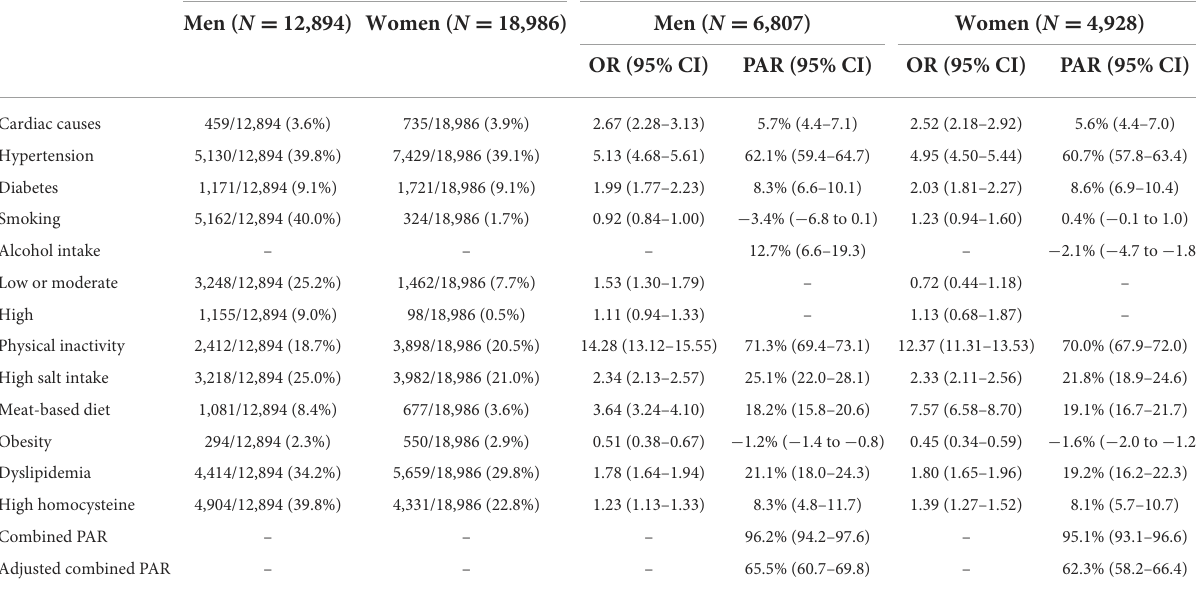
TABLE 1 Risk factors for all stroke in men and